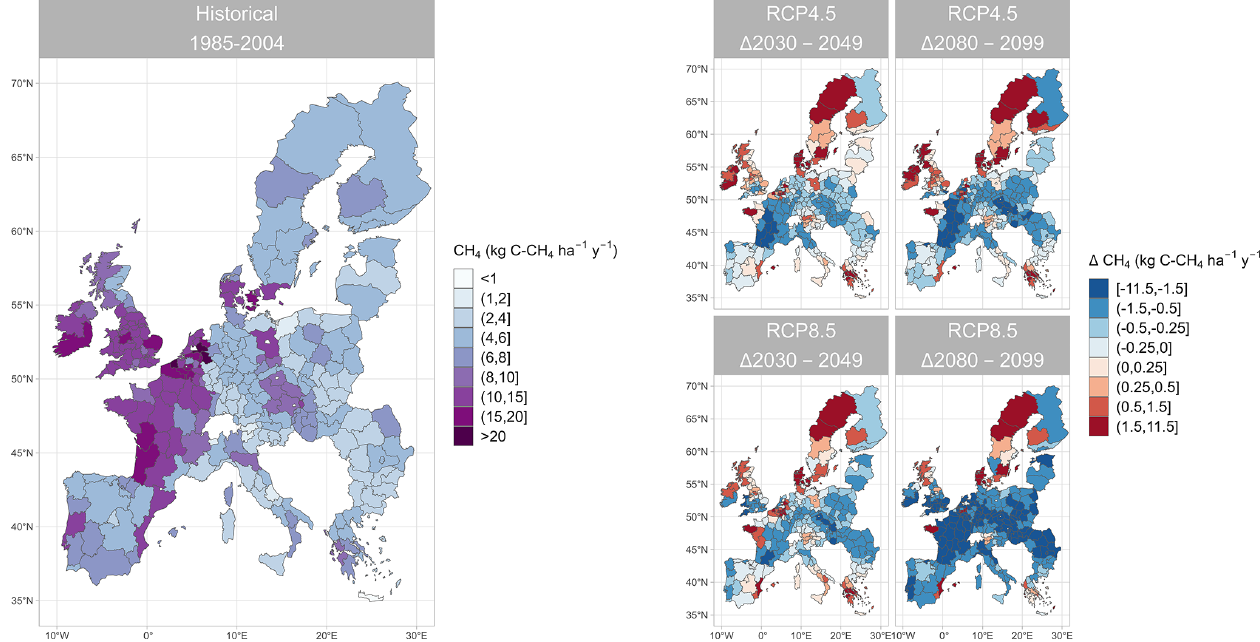
Figure 9. CH 4 emissions for grasslands in European administrative borders (NUTS2). Emissions are reported for the historical period (1985– 2004) and difference (cid:49) from the middle (2030–2049) and the end (2080–2099) of the century for the two climatic scenarios, RCP4.5 and RCP8.5.